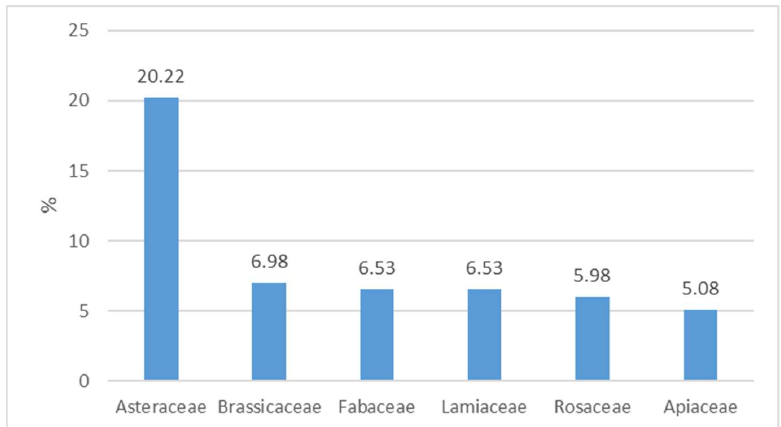
Figure 2. Percentage composition of the main families of Italian Wild Edible Plants (WEPs).